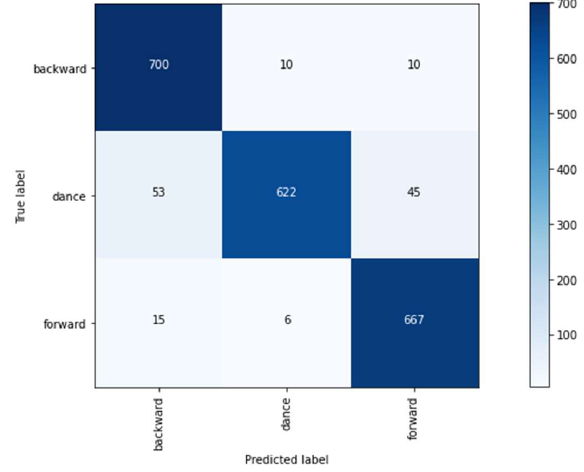
Figure 15. Confusion matrix of left classifier.